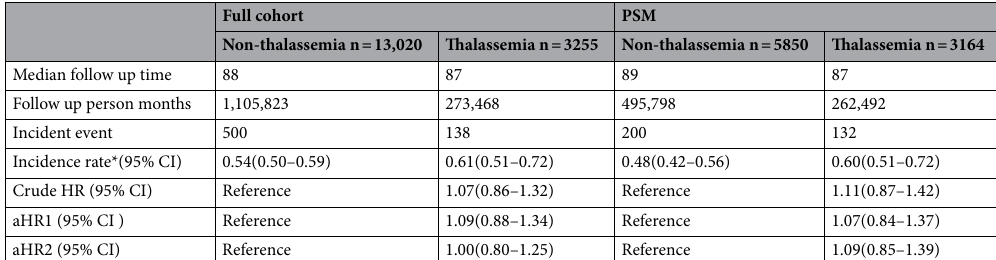
Table 2. Incidence of gout in study groups†. *Incidence rate, per 100 patients-year. † aHR1, adjusted hazard ratio, the co-variates including demographic variables (like sex, age, urbanization, and insured type). aHR2, adjusted hazard ratio, the co-variates including demographic variables (such as sex, age, and insured type), and comorbidities.